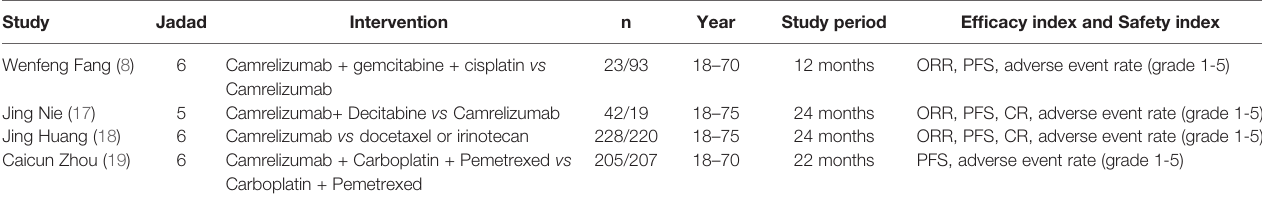
TABLE 1 | Characteristics of included studies and Jadad scores.